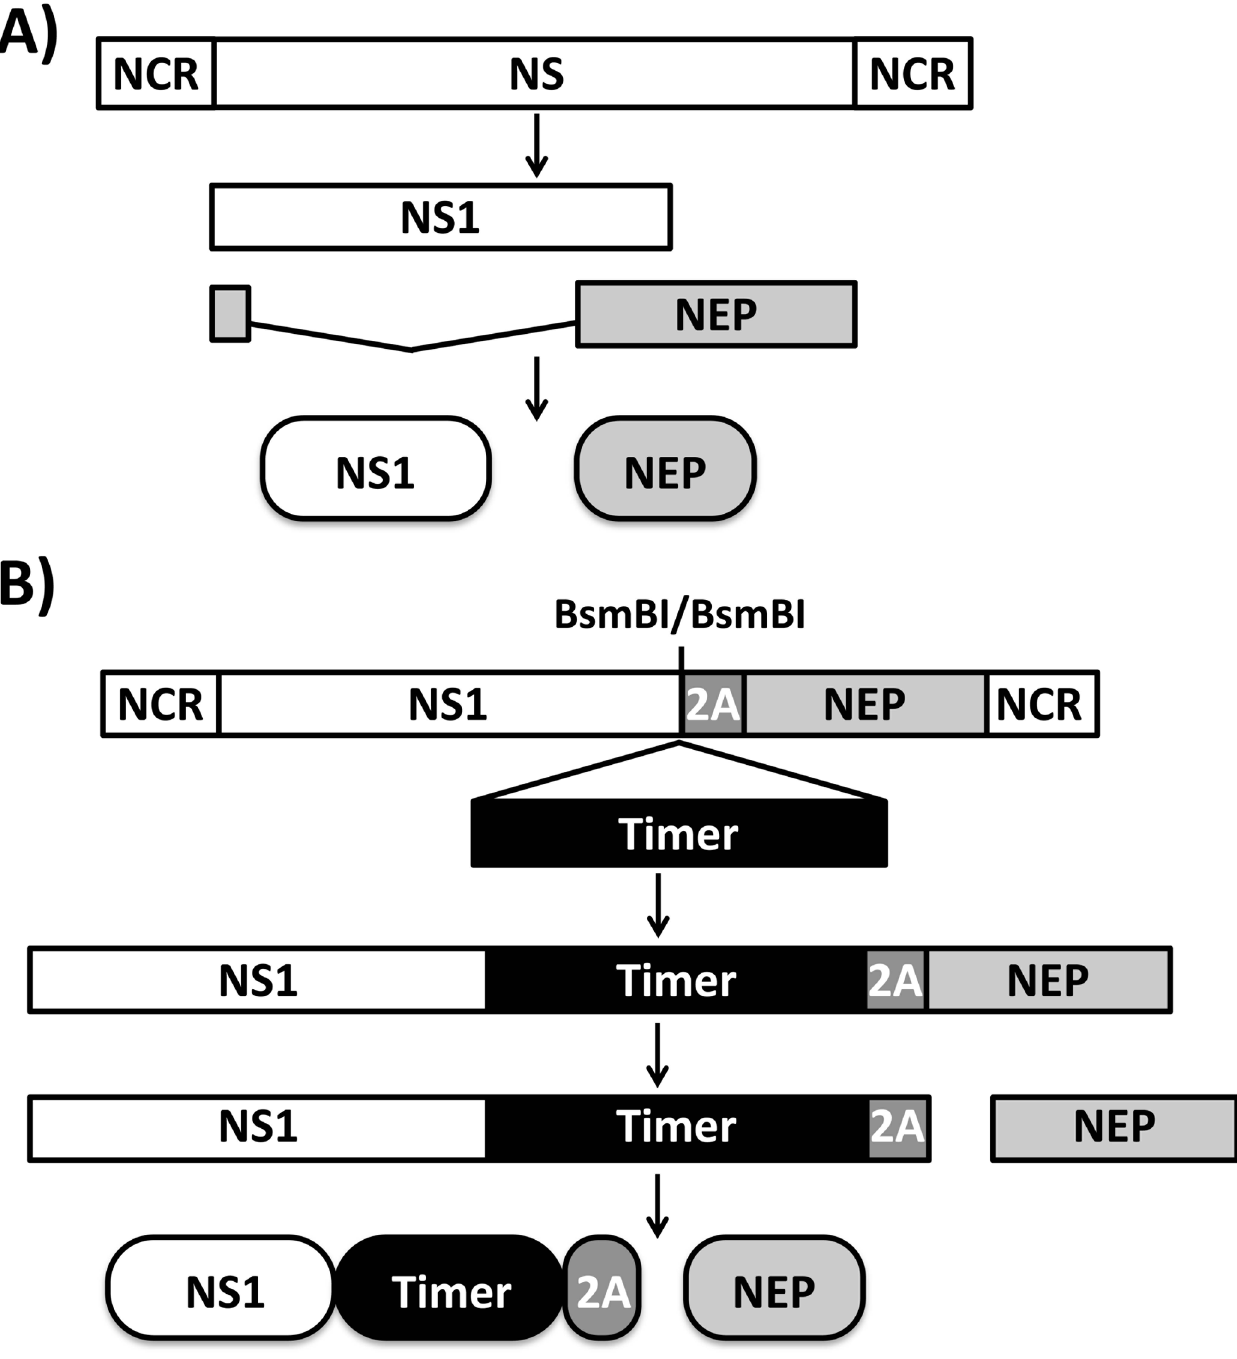
Fig 1. Schematic representation of wild-type (A) and Timer-expressing (B) influenza A and B NS segments. Influenza NS segment viral products are indicated by white (NS1) or gray (NEP) boxes. Timer fluorescent protein and the porcine teschovirus-1 (PTV-1) 2A site are indicated by black and gray boxes, respectively. NCR, non-coding regions. BsmBI restriction sites used to clone Timer between NS1 and PTV-1 2A are